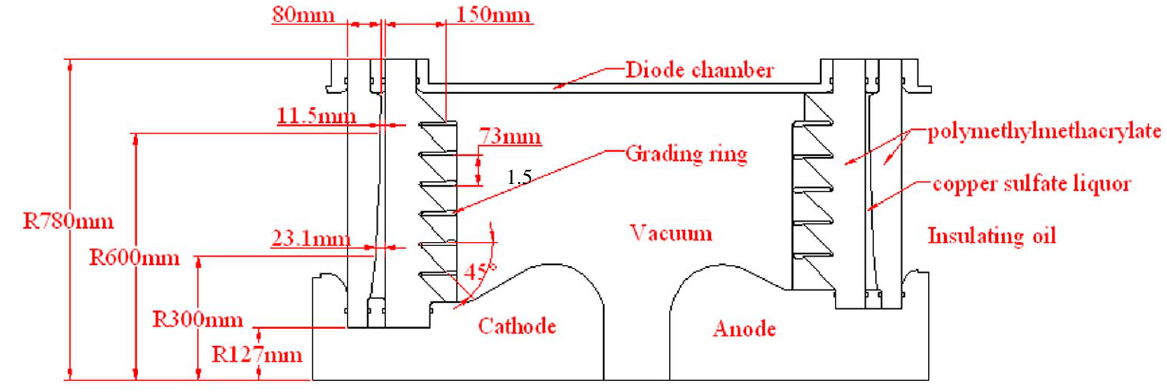
FIG. 11. (Color) Structure and dimension of the radial insulator.